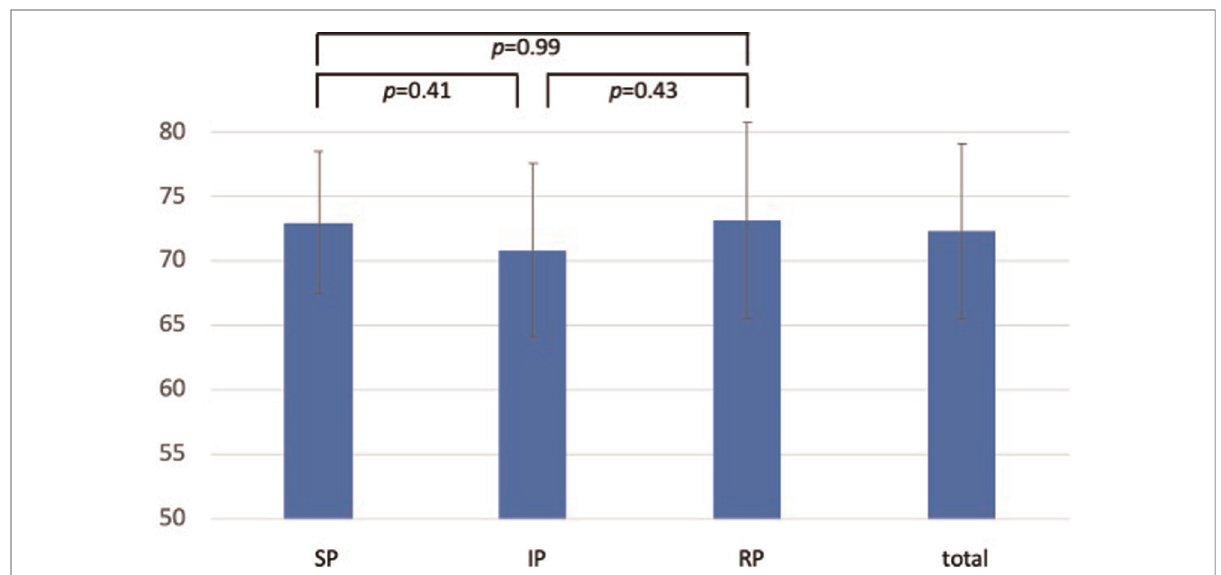
FIGURE 3 OSCE results: total rating. Results of the overall OSCE rating with the fi rst part of the evaluation sheet weighted as two-thirds and the second part weighted as one-third of the score. Data are presented as the mean±standard deviation of the achieved results as a percentage. (SP-group, simulated patient group; IP-group, incognito patient group; RP-group, real patient